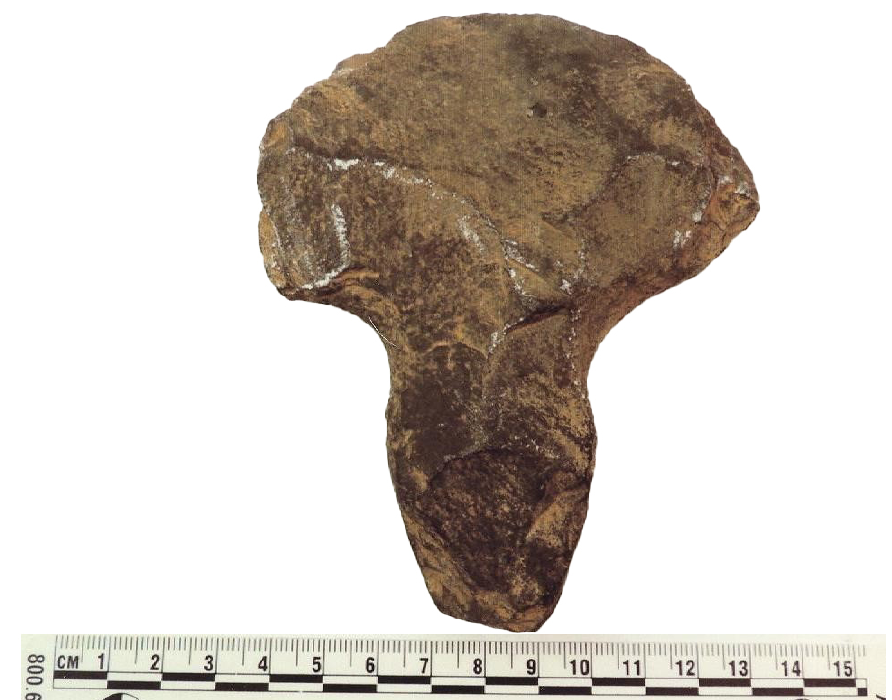
Figure 3. Photograph of Rounded (Crescent or Curved) variety (by Healy, courtesy of the Cambridge University Museum of Archaeology and Anthropology; Cat. No. 1946.166B; scale in